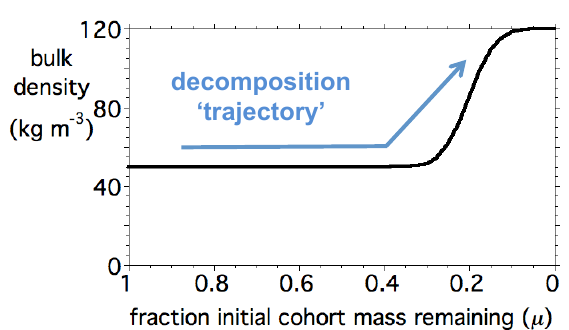
Fig. 3. Peat cohort bulk density ( ρ ; Eq. 10) as a function of de- gree of decomposition (as fraction of initial mass inputs remaining, m/m 0 ) . This curve uses the parameterization in Table 2, with a minimum bulk density of 50kgm − 3 and a maximum bulk density of 120kgm − 3